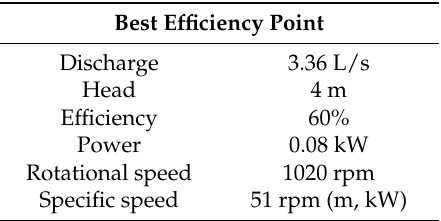
Table 1. Best efficiency point provided by the manufacturer.